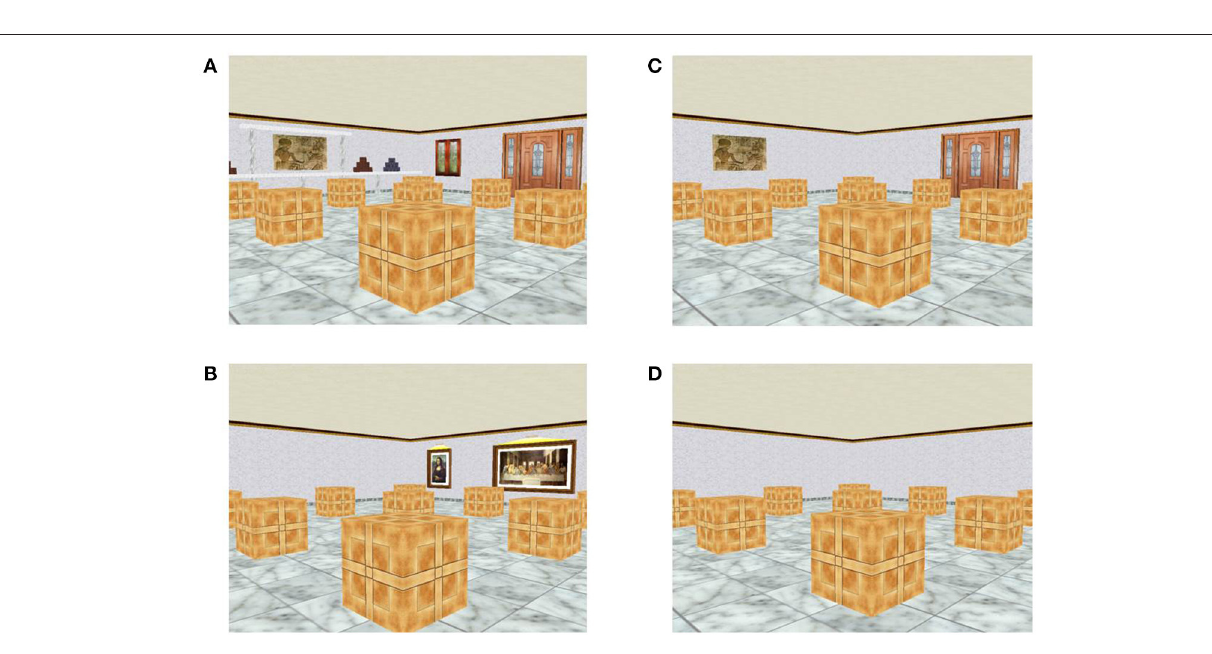
FIGURE 2 | Different conditions applied in the spatial recognition task. (A,B) Different perspectives of the room with all landmarks available (AL condition). (C,D) Different perspectives of the room with only two landmarks available (2L condition). Note that two walls did not contain any